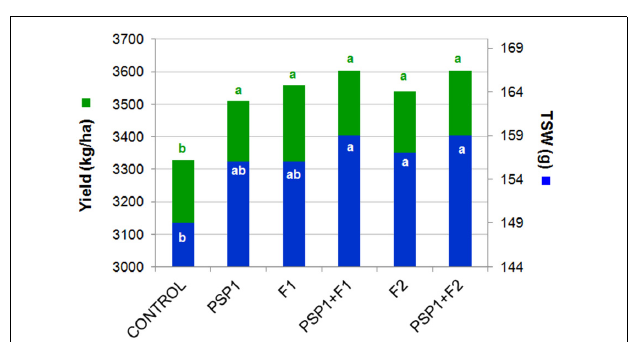
FIGURE 3 | Soybean field trial in Tandil during growing season 2013/14. Yield (kg/ha) and TSW (g) were determined. All treatments were performed when soybean crop had reached the reproductive phenological stage R3. Control plants received standard soybean crop management without foliar fungicide application. F1 dosage = 150 ml/ha, F2 dosage = 400 ml/ha and PSP1 dosage = 2,000 ml/ha. Different letters in each column indicate statistically significant differences (according to Tukey’s HSD test; p <